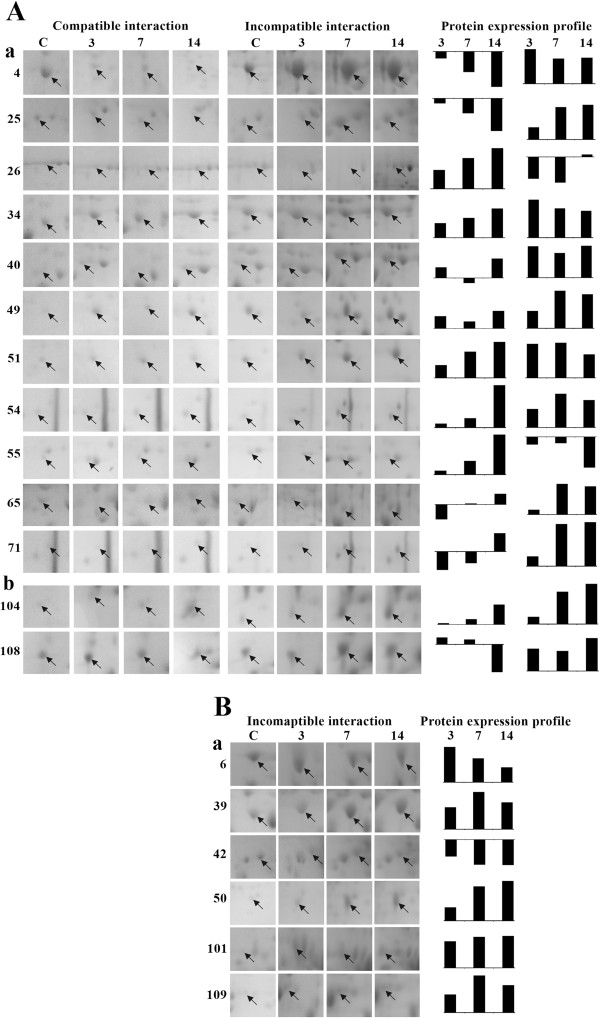
Differentially abundant proteins on 2 DE gels during compatible and incompatible interaction between MYMIV and V. mungoleaf proteome. (A); only during incompatible interaction (B). Stress/defense related proteins (a); Signal transduction related proteins (b). Arrows indicate proteins whose expression changed in response to virus infection.